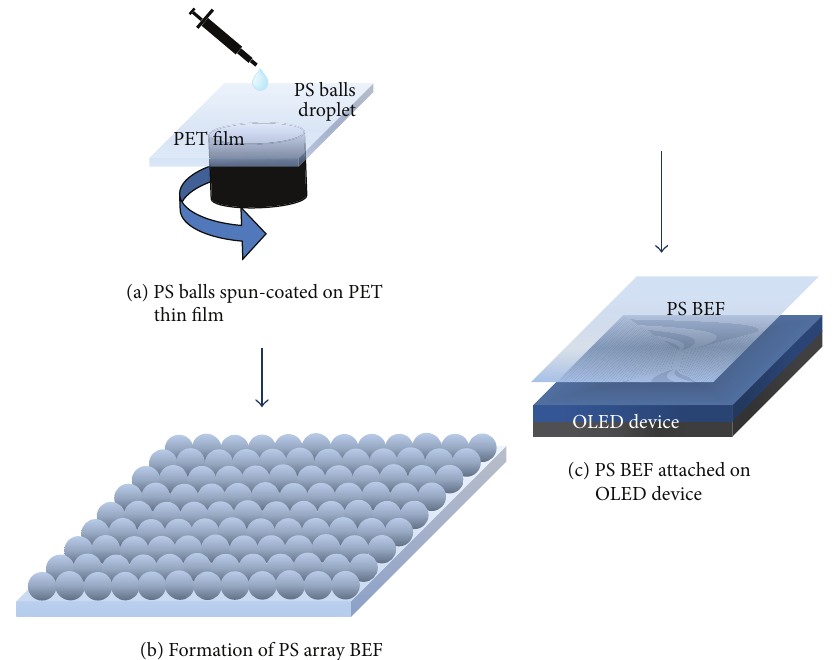
Figure 1: The schematic diagrams of (a) the fabrication procedures for (b) the preparation of single-monolayered self-assembled polystyrenes (PS) arrays, and then (c) the brightness enhancement film (BEF) and its application attached onto organic light-emitting diodes (OLEDs)